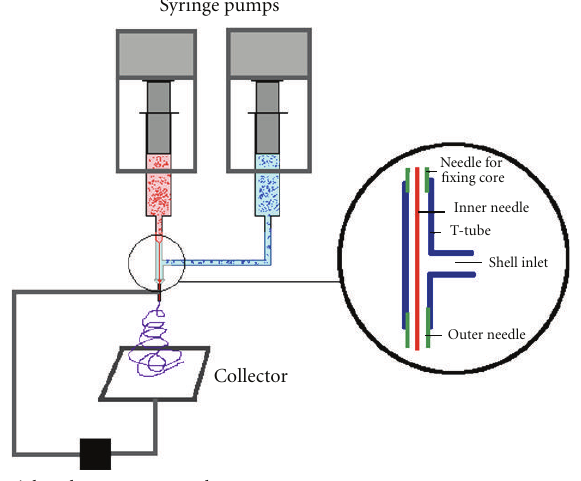
Figure 1: Illustration of the core-shell setup for electrospinning hollow